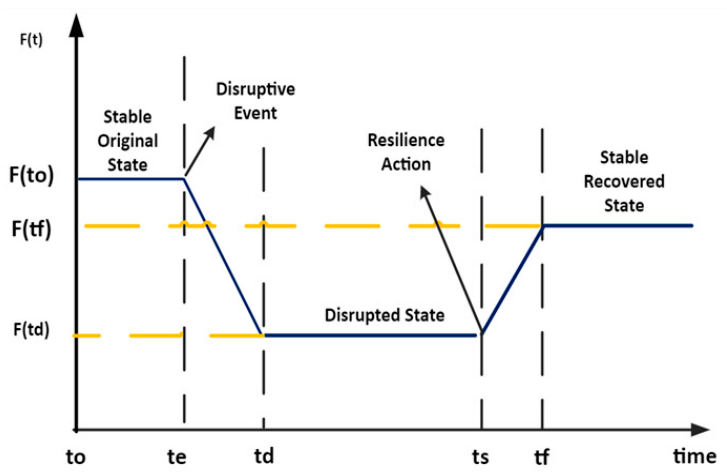
Figure 16. Service function depending on time.